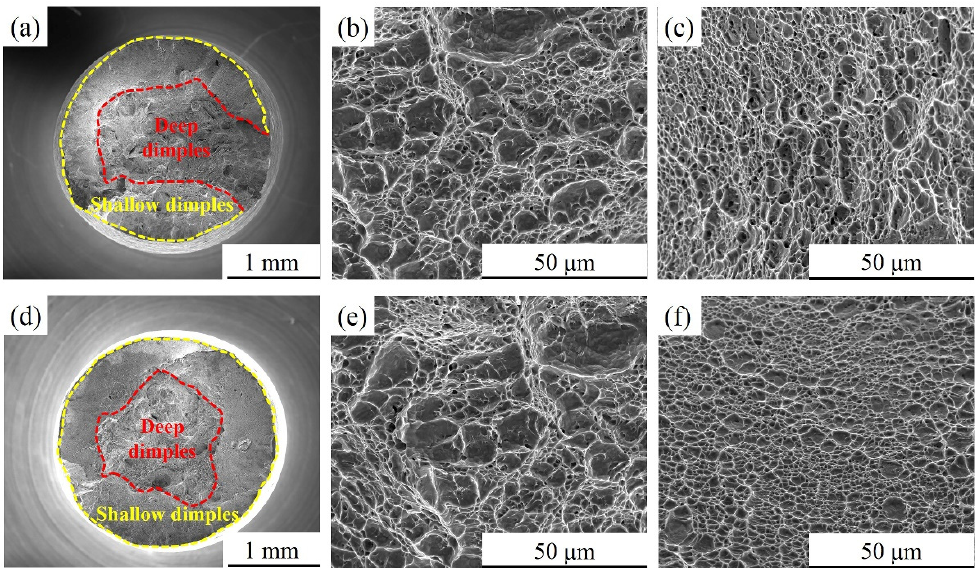
Figure 10. SEM fractographs of DC after SSRTs in air and 3.5 wt.% NaCl solution: ( a – c ) air and ( d – f ) 3.5 wt.% NaCl solution.